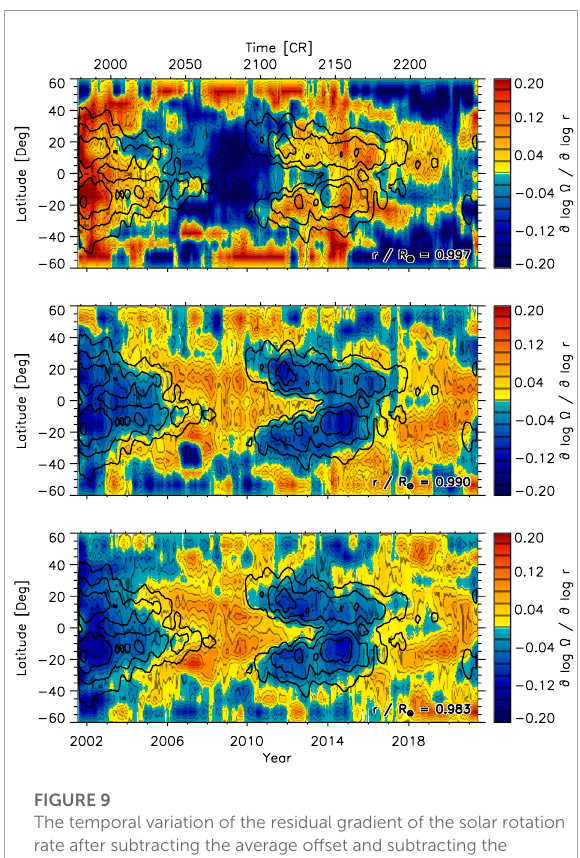
FIGURE 9 The temporal variation of the residual gradient of the solar rotation rate after subtracting the average offset and subtracting the temporal mean at every latitude at three depths (top: .997 R ⊙ , middle: .990 R ⊙ , bottom: .983 R ⊙ ) smoothed with a rectangular boxcar over 13 CRs derived from GONG data. The time coordinate is given in years (bottom x-axis) and CRs (top x-axis). Black contours indicate magnetic activity (5, 10, 20, 40 G) smoothed over five CRs. Compare with Figure 8